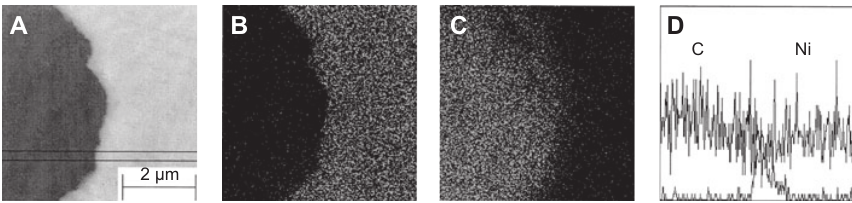
Figure 7 Interface between HM fi ber and nickel after heat treatment at 1100 ° C for 9 h. (A) SEM image at the interface. (B) Ni distribution by EDX. (C) C distribution by EDX. (D) C and Ni distribution between two lines in the left photo by Figure 7 A. The results of compositional analysis by EDX are shown in photos (B) and (C). The result of line analysis between two lines in the photo (A) is shown in (D). There is